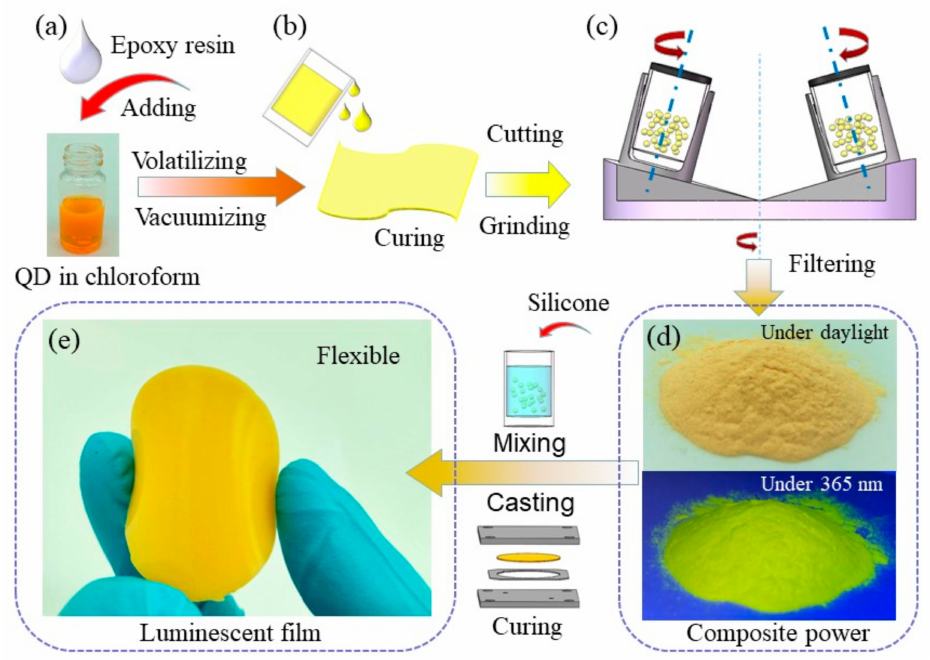
Figure 1. ( a – c ) Fabrication process of QD/epoxy composite particles. ( d ) Images of composite particles under daylight and 365 nm. ( e ) Images of flexible luminescent film fabricated by mold casting